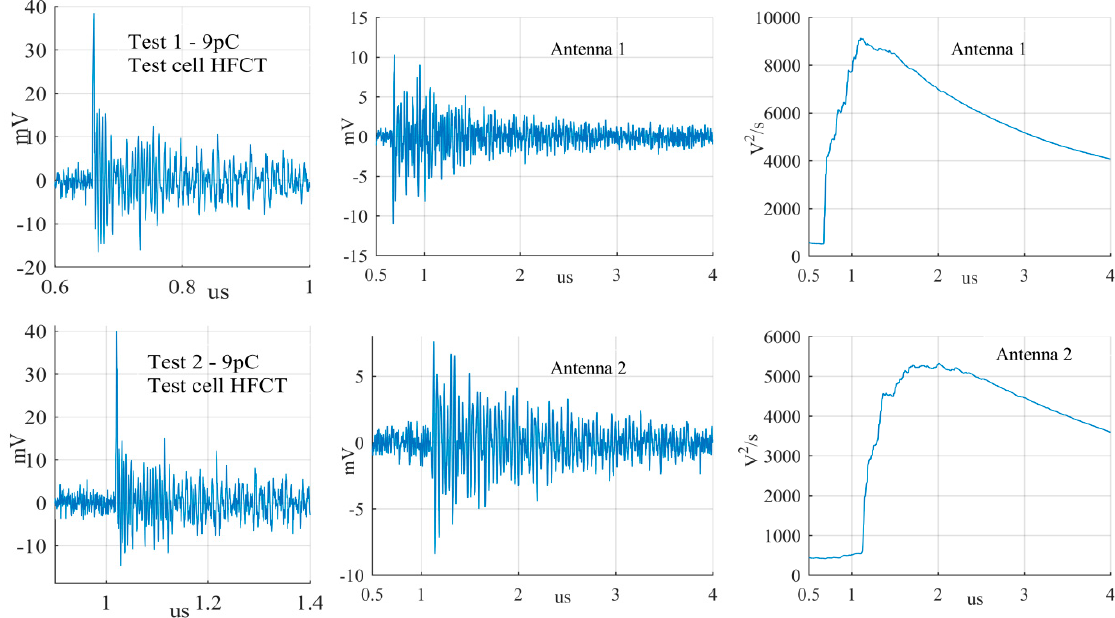
Figure 17. Smallest free moving particle discharge from the antenna at position 1 and 2.